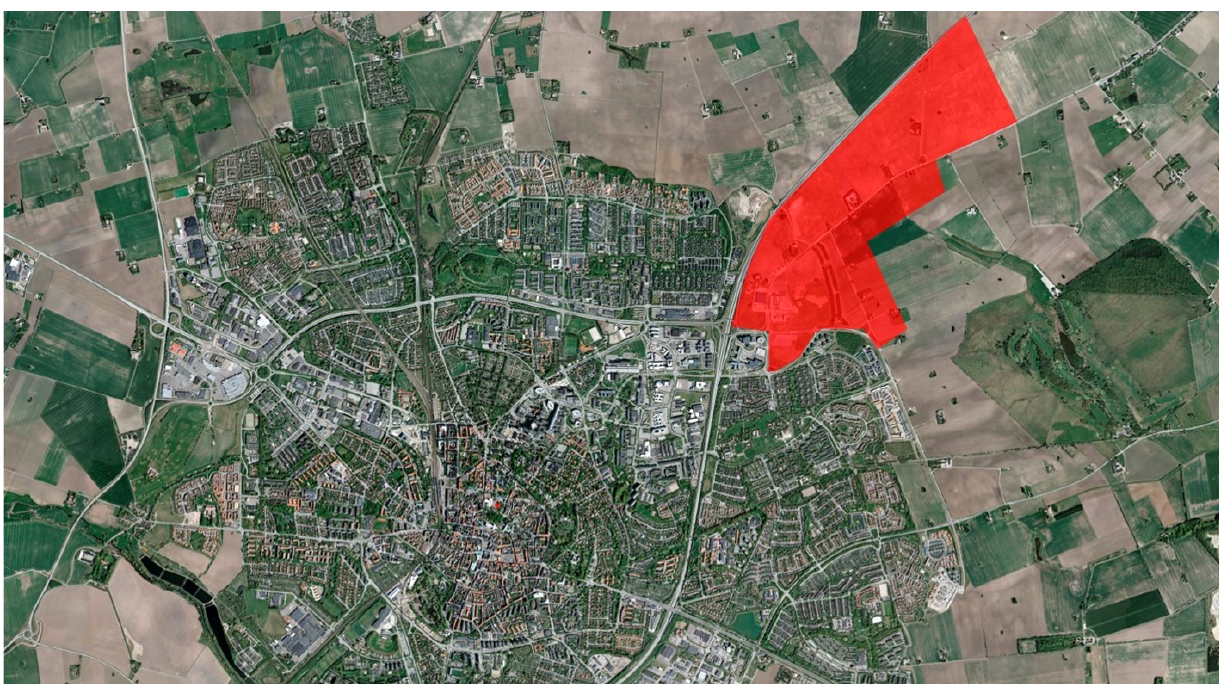
Figure 1. Map of Brunnshög (marked in red) and Lund City. Source: Courtesy of Lunds